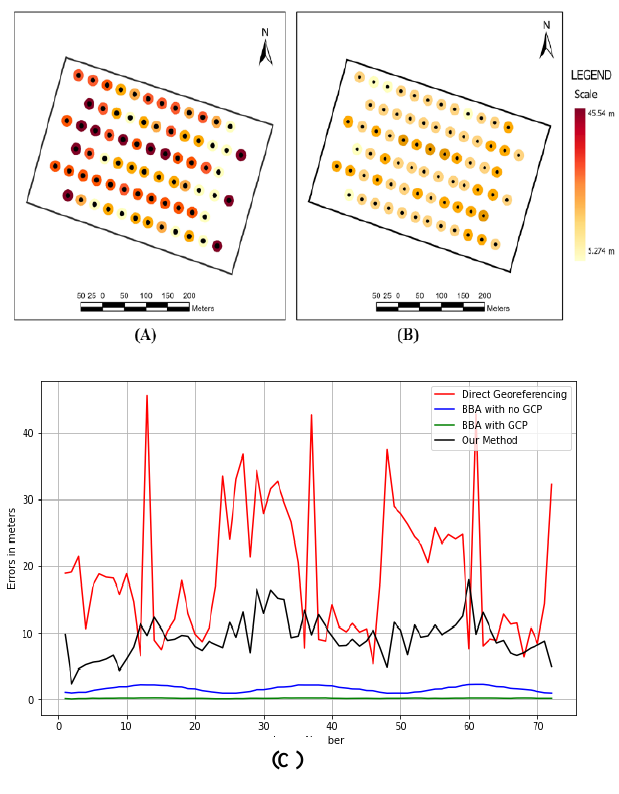
Figure 8. Analysis of Mean Absolute Error for positional accuracy using (A) initial direct georeferencing method without correction, (B) improved MAE from our method and (C) a